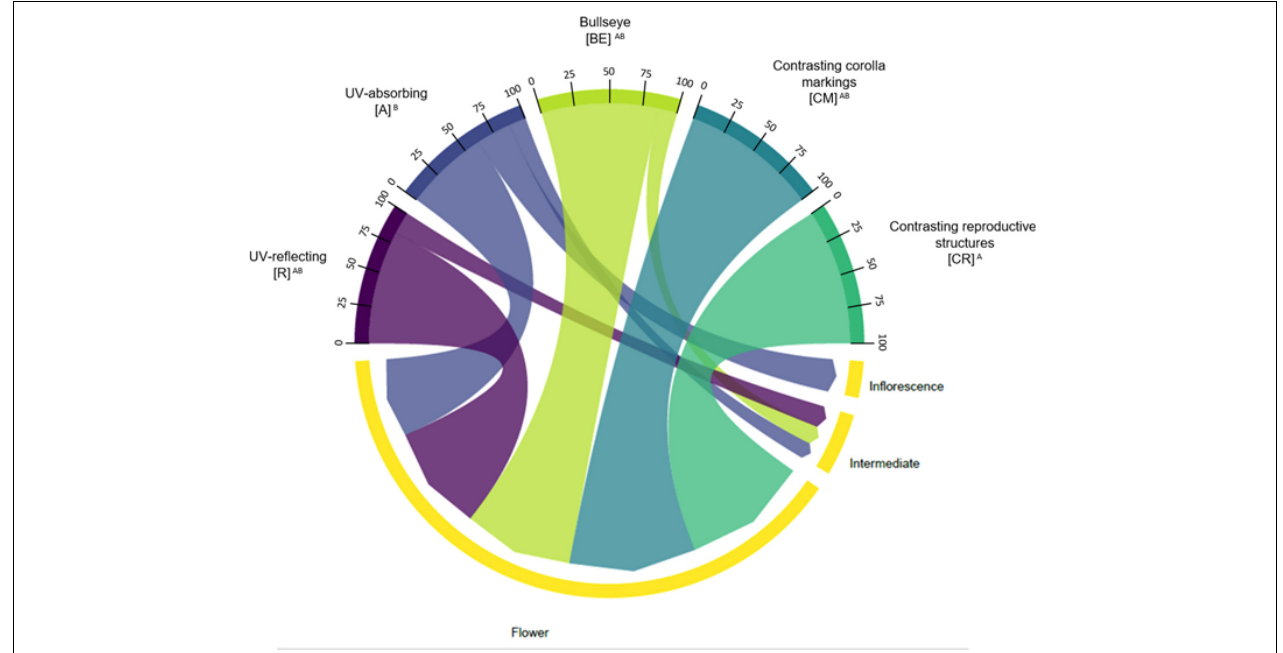
FIGURE 10 | Chord diagram showing the relationship between the types of floral UV features and the type of attraction unit of 80 plant species. The chords are unidirectional. Chord thickness corresponds to the percentage of species with each UV feature that is related to a given attraction unit. Flowers within each UV category presented different percentages of species with each attraction unit type ( χ 2 = 12.33; p = 0.01506). See Supplementary Tables 7 , 8 for percentages. R, non-patterned UV-reflecting; A, non-patterned UV-absorbing; BE, bullseye; CM, contrasting corolla markings oriented towards floral resources; CR, contrasting reproductive structures.